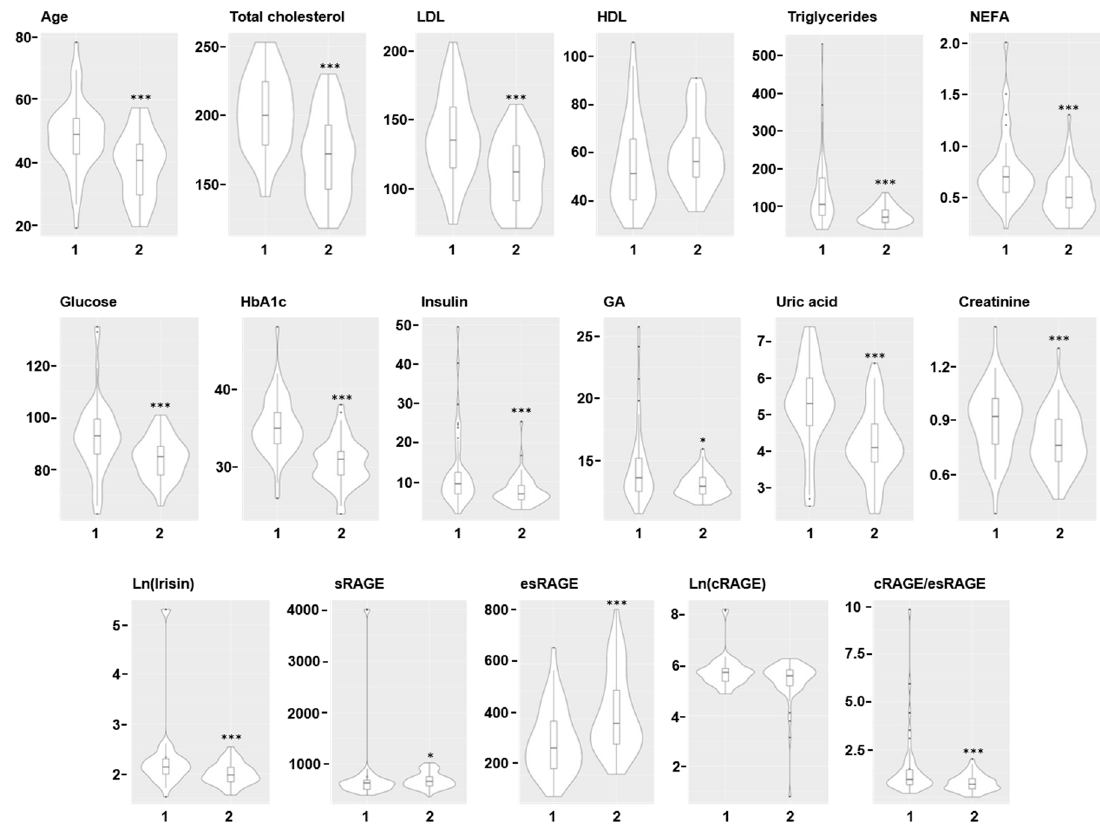
Figure 2. Main characteristics of the individuals included in the two clusters. Table 3. Subjects characteristics and risk factors in the two clusters of